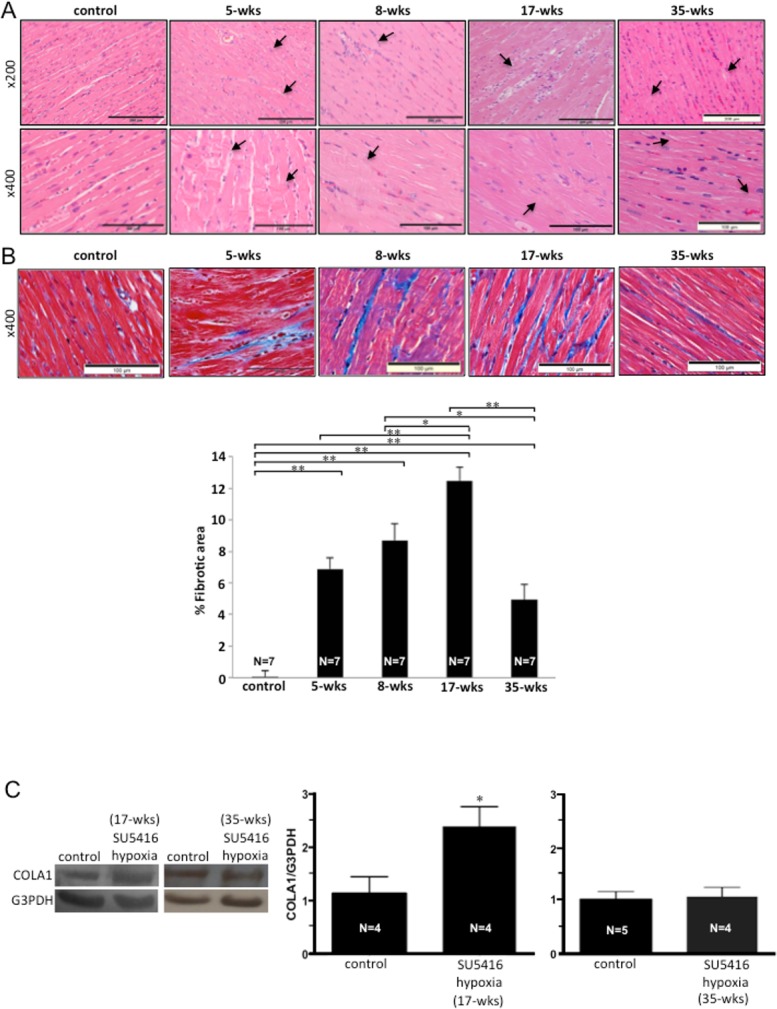
RV damage and fibrosis.SU5416-injected rats were subjected to 3 weeks in hypoxia and then maintained in normoxia for 2, 5, 14 or 32 weeks (5-, 8-, 17- and 35-wks time points, respectively). (A) Representative H&E staining results of the RV tissue sections. (B) Masson’s trichrome stain results in the RVs. Blue stains indicate fibrotic areas. Bar graph represents means ± SEM of % fibrotic area (N = 7). *Significantly different from each other at P < 0.05. **Significantly different from each other at P < 0.01. (C) Western blotting showing COLA1 expression as an indicator of fibrosis in the RVs at 17 and 35 weeks after the SU5416 injection. Bar graph represents means ± SEM of the ratio of COLA1 to G3PDH. *Significantly different from the control value.